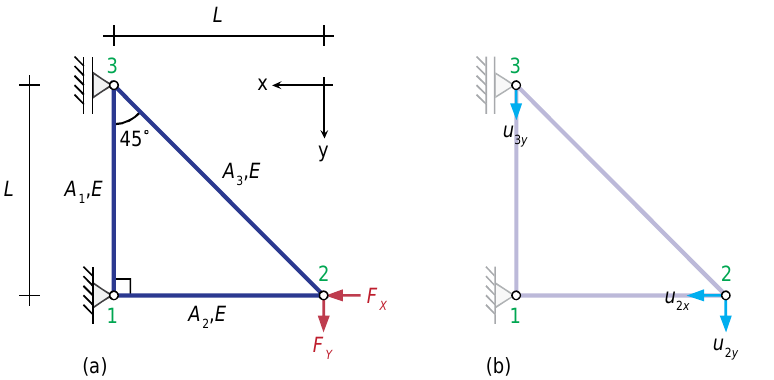
Figure 4. Three-bar truss: ( a ) Coordinate system and loading and boundary conditions, and ( b ) displacements at nodes 2 and 3.